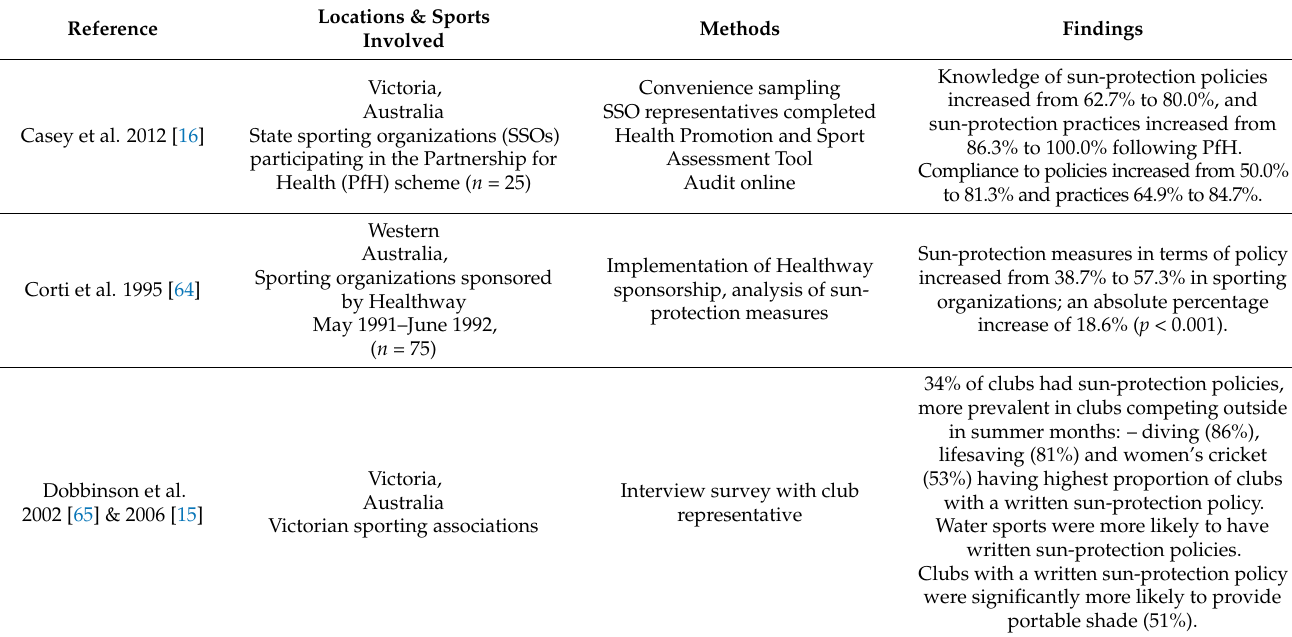
Table 2. Summary of findings regarding sun-protection policy in sports in Australasia obtained from literature published in English between January 1992 and August